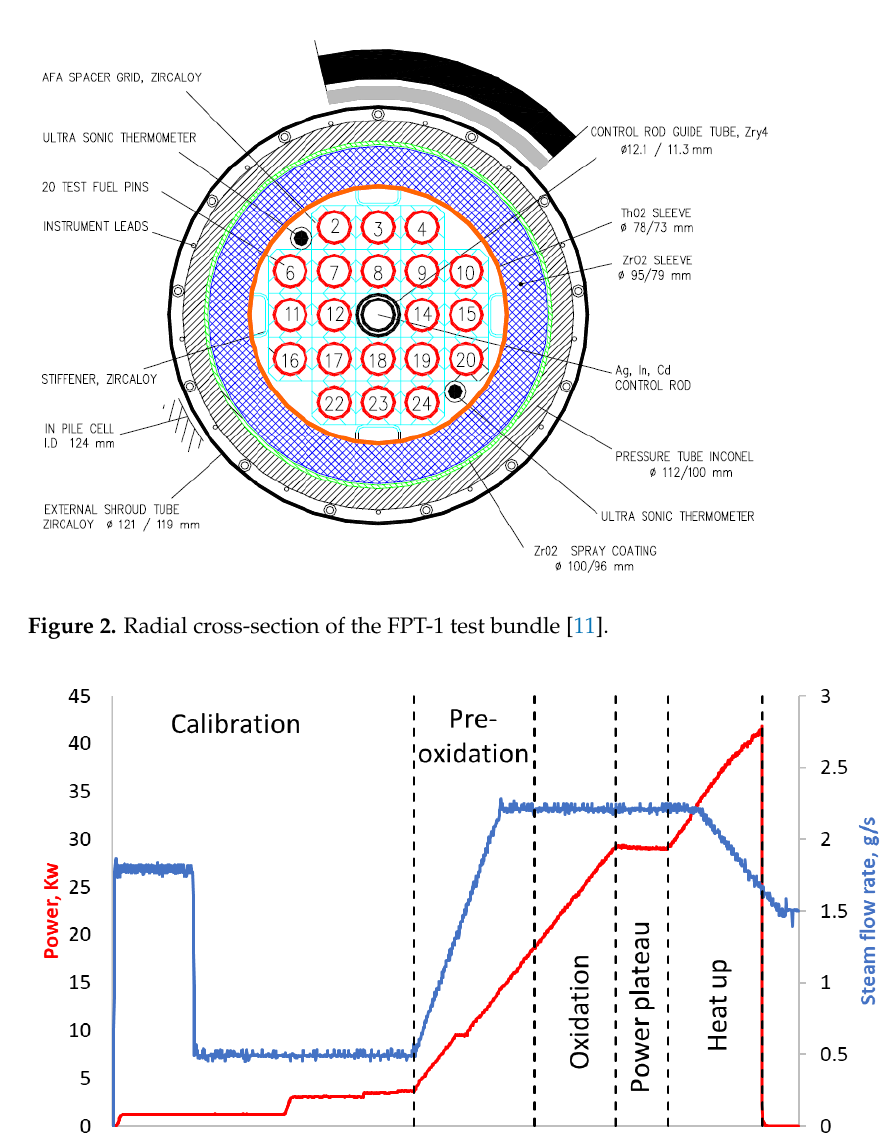
Figure 3. Power of the bundle and steam flow rate through the bundle, experimental